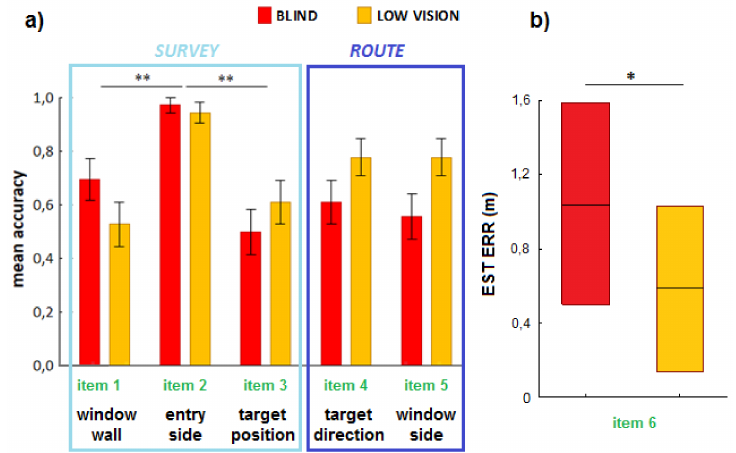
Figure 3. ( a ) Accuracy scores for each item of the MCQ by level of visual disability. Asterisks indicate higher accuracy for Item 2 than Items 1 and 3, both for blind (BLI) and low-vision (LOW) participants. **, p < 0.01; ( b ) Estimation error (m) relative to the distance to reach the target location. Asterisk indicates a significantly larger estimation error in the BLI compared to LOW participants. *, p <